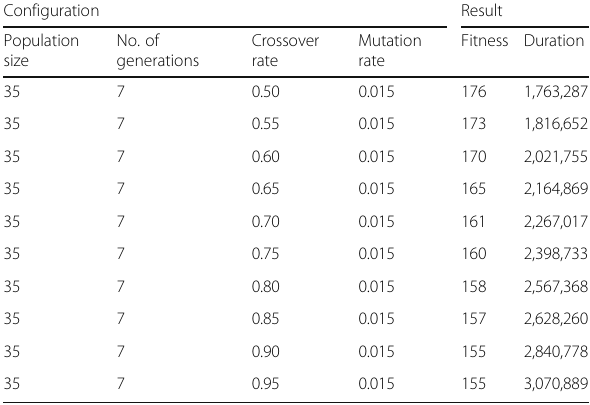
Table 15 The impact of the crossover rate on the genetic algorithm accuracy